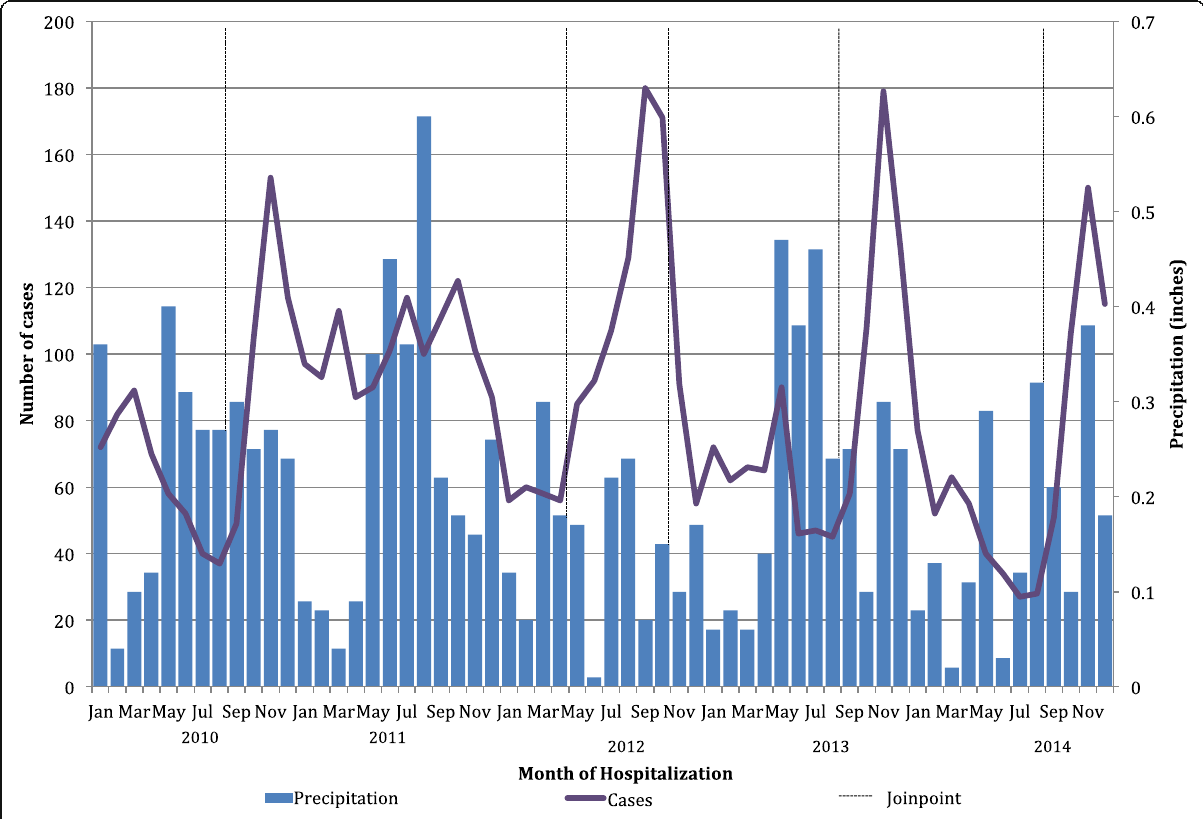
Fig. 2 Association between monthly cumulative frequency of bronchiolitis hospitalizations and rainfall, 2010 –